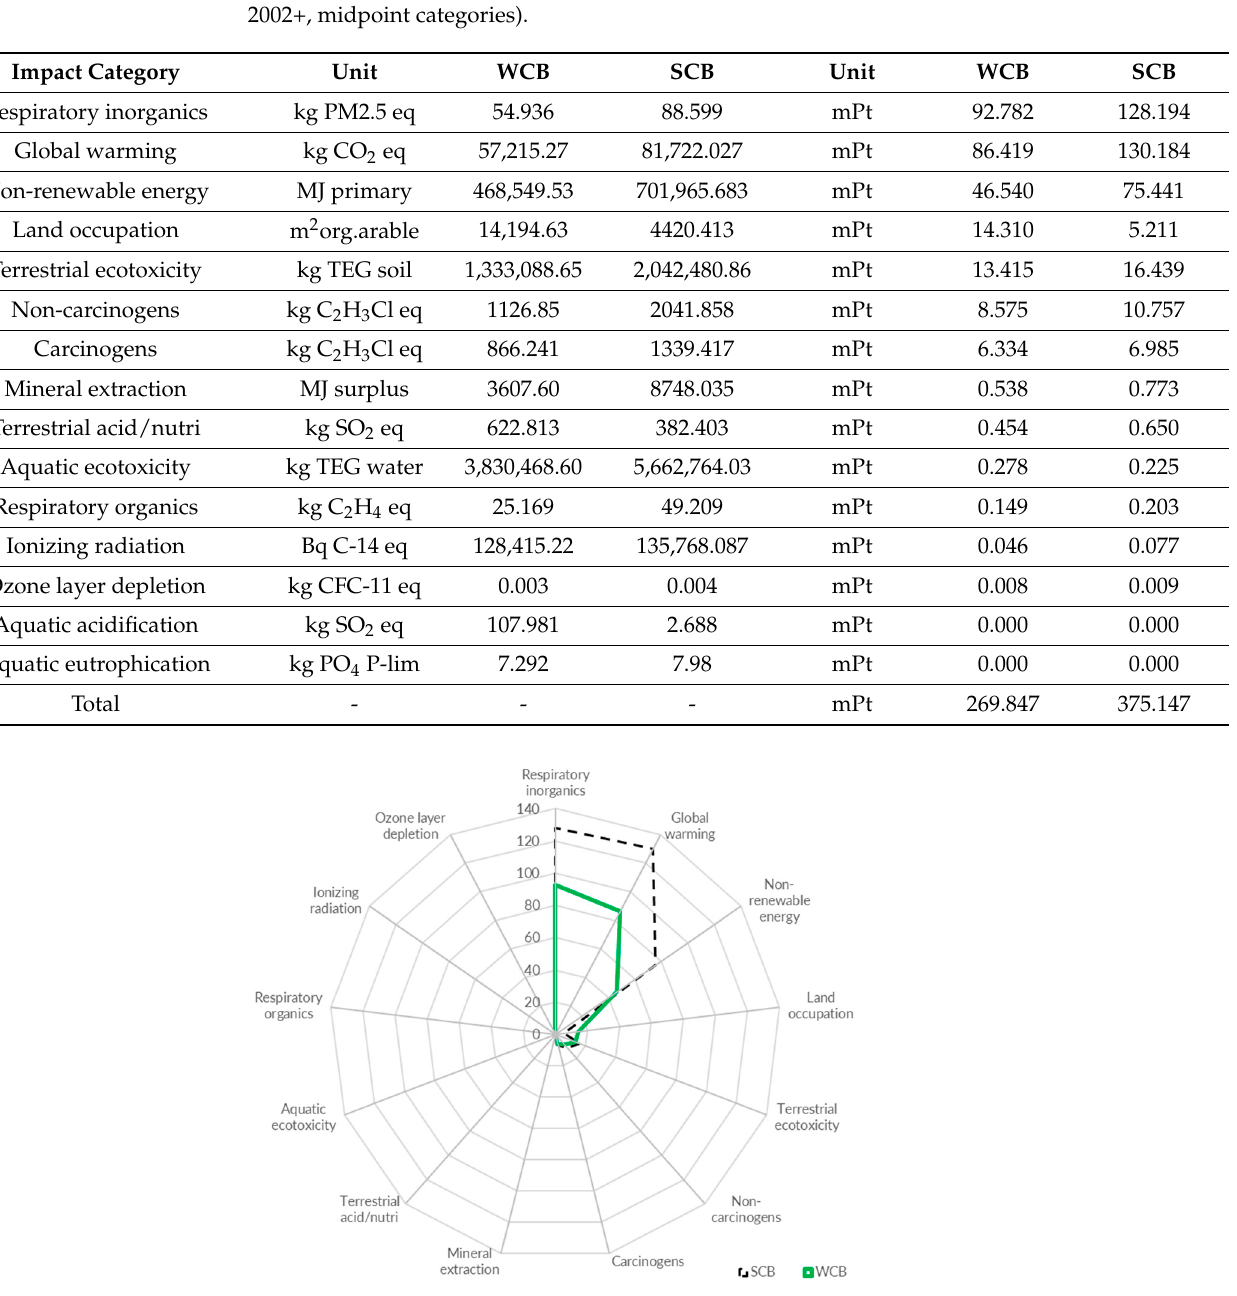
Figure 8. Comparison of WCB and SCB environmental damage (mPt) per m 2 (SimaPro, IMPACT 2002+, midpoint categories).